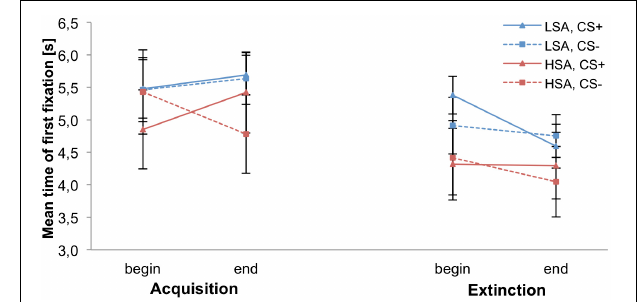
FIGURE 4 | Mean duration of approach for low (LSA) and high socially anxious (HSA) participants ( n = 53). CS+ = agent paired with aversive unconditioned stimulus (US); CS − = agent without aversive US; NS = agent without aversive US and only appearing during the extinction phase. Standard errors are presented by error bars.